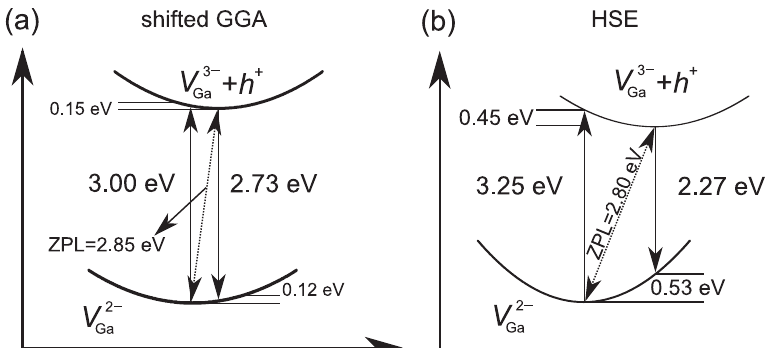
Fig. 5 Comparison of the a GGA- and b HSE-calculated CC diagrams for optical transitions involving capture of a hole by V 3 (cid:2) Table 1. Gallium-vacancy-related levels that can give rise to yellow